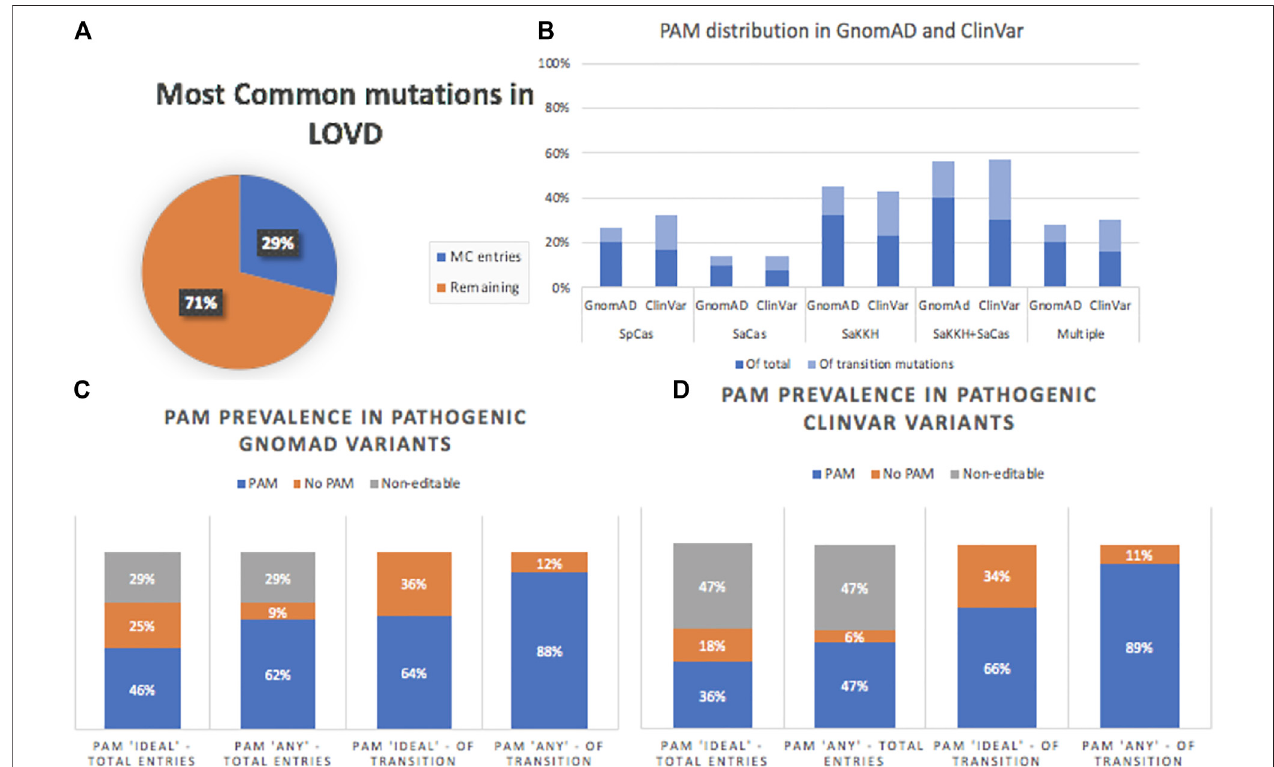
FIGURE 4 | A) LOVD analysis was in fl uenced by entry numbers, where 29% of entries consisted of the fi ve most common (MC) mutations (c.5882G > A, c.5461- 10T > C,c.2588G > C,c.3113C > T,andc.1622T > C. (B) DistributionofthevariousPAM-sitesbydatabase.GiventhelargeeditingwindowofSaKKH,thiswasthemost prevalent PAM/Cas in both databases. The columns are additive — dark blue represents the percentage of total entries, whereas the percentage indicated by the light blue bar is taken out of the transition mutations. LOVD was excluded from this analysis as it was based on entry number. (C) and (D) PAM prevalence in gnomAD and ClinVar databases. “ Ideal ” PAM proximity accounted for 46 and 36%, respectively, of “ pathogenic ” and “ likely pathogenic ”